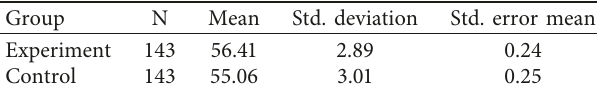
Table 3: Homogeneity of variances test. Table 4: Results of t -test in posttest of the experimental and control